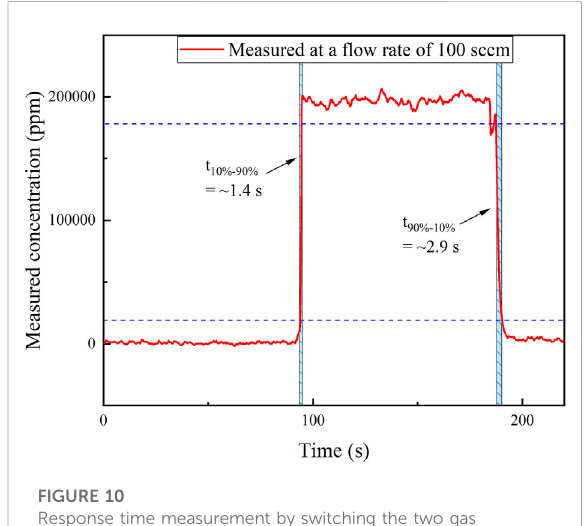
FIGURE 10 Response time measurement by switching the two gas samples with a concentration level of 0 ppm (N 2 ) and 10%.